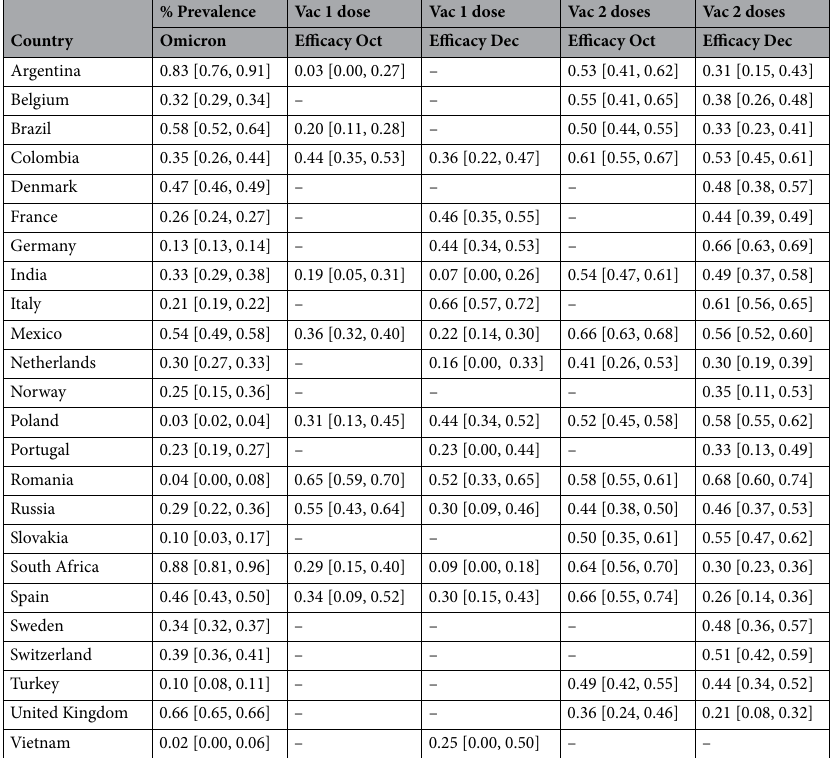
Table 3. Prevalence of Omicron and vaccination efficacy with one and two doses in the countries with presence of Omicron (as defined in Section “Countries and time periods”). When data is insufficient to meet the defined selection criteria, it is omitted and replaced by “–”. The prevalence of Omicron is replicated from Table 2 for easy